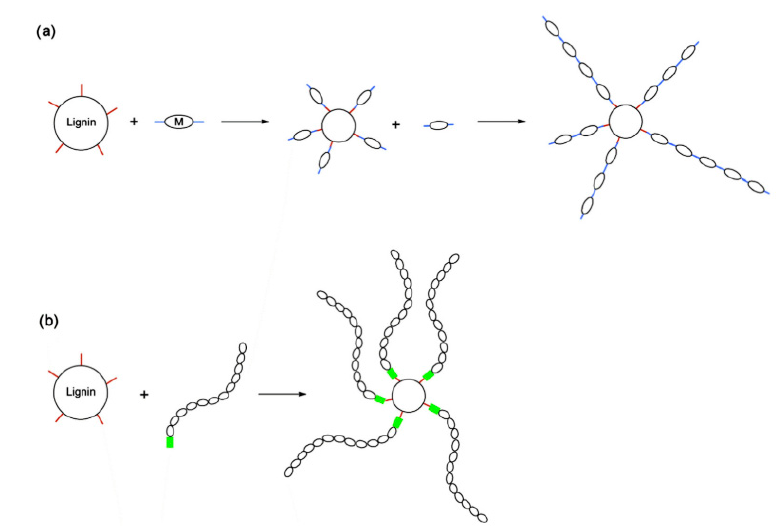
Figure 11. Schematic synthesis of lignin graft copolymers by “grafting from” ( a ) and “grafting onto” ( b ) techniques [1].